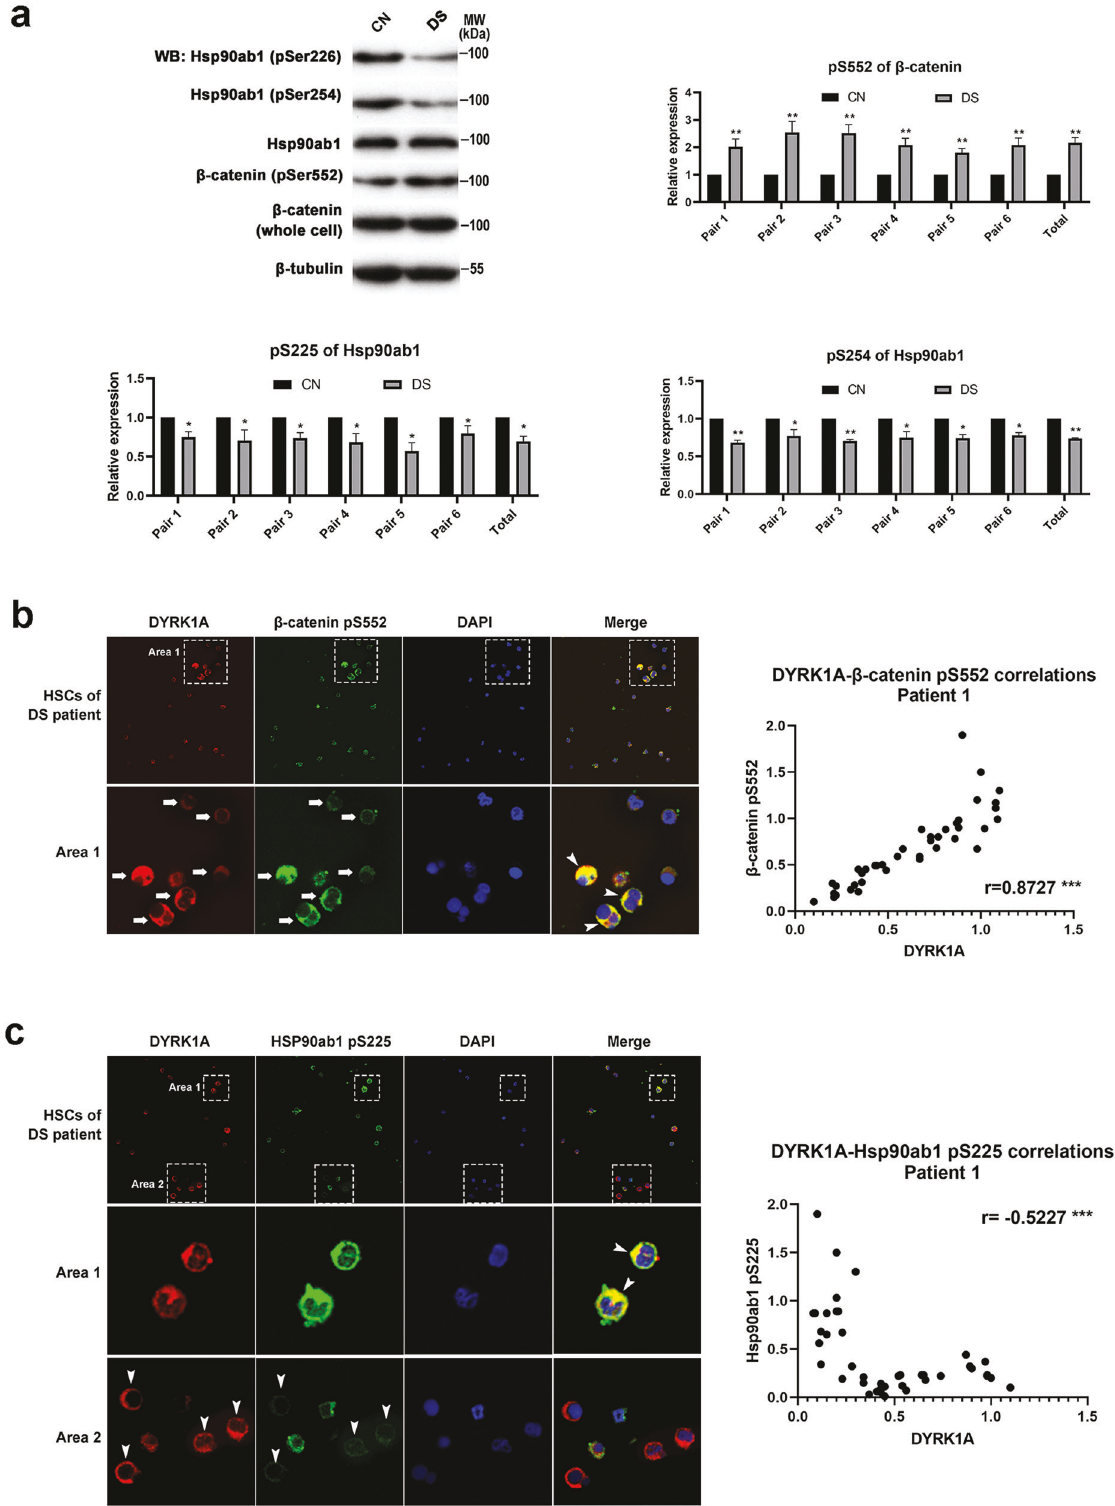
Fig. 5 The uncovered molecular mechanism from the zebra fi sh DS embryo model is conserved in DS patients. a Representative western blot assay and corresponding statistics to detect the phosphorylation sites of β -catenin and Hsp90ab1 in amniocytes. b DYRK1A expression positively correlated with the phosphorylation level of β -catenin Ser552 site in HSCs from DS patients. Arrows show the detected HSCs, arrowheads show the colocalization of two proteins. c DYRK1A expression negatively correlated with the phosphorylation level of the Hsp90ab1 S225 site in HSCs from DS patients. Arrowheads in Area 1 show the colocalization of two proteins, and arrowheads in Area 2 show the detected HSCs.